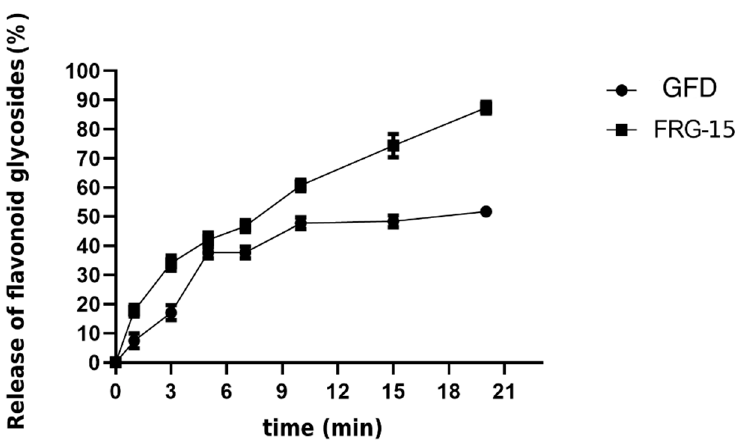
Figure 2. In Vitro release profile of flavonoid glycosides from film based on CMC with incorpo- rated G. biloba ethanol extract of FRG—15 formulation and G. biloba freeze-dried extract (GFD). Three selected flavonoids—quercetin, kaempferol and isorhamnetin—were identi-